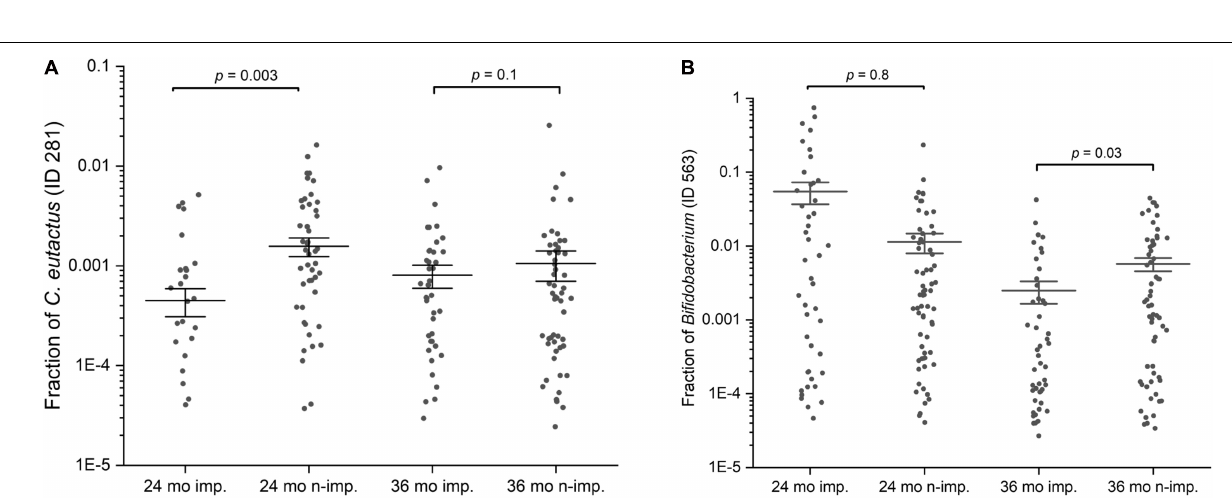
Frontiers in Microbiology |